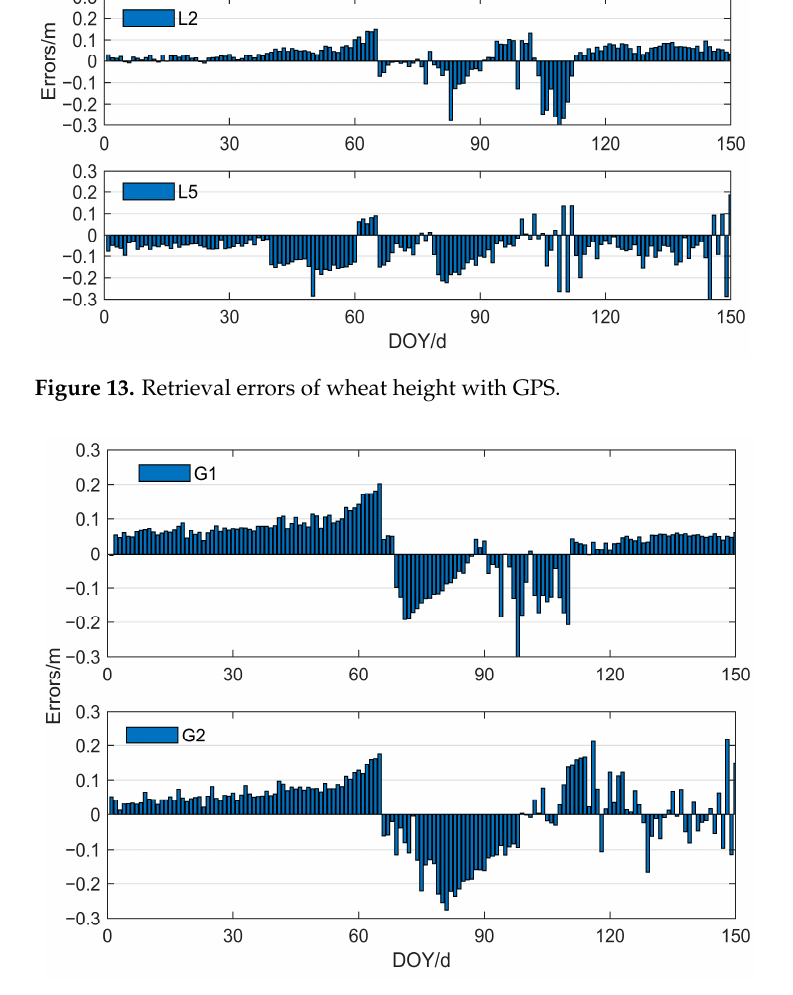
Figure 14. Retrieval errors of wheat height with GLONASS.